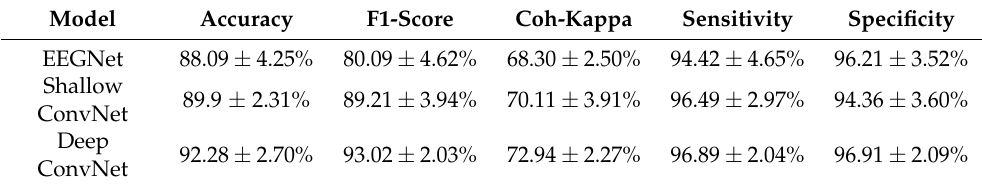
Table 2. Five-fold classification performance for transition to FOG vs. transition to voluntary stopping.